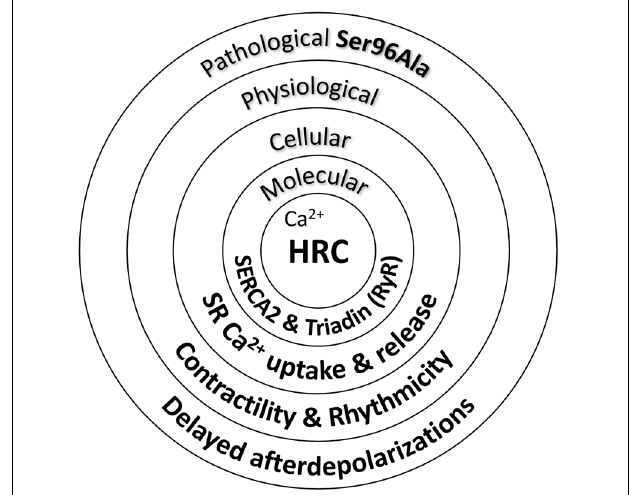
FIGURE 2 | Histidine-rich calcium binding protein functional significance in cardiac physiology and pathophysiology.